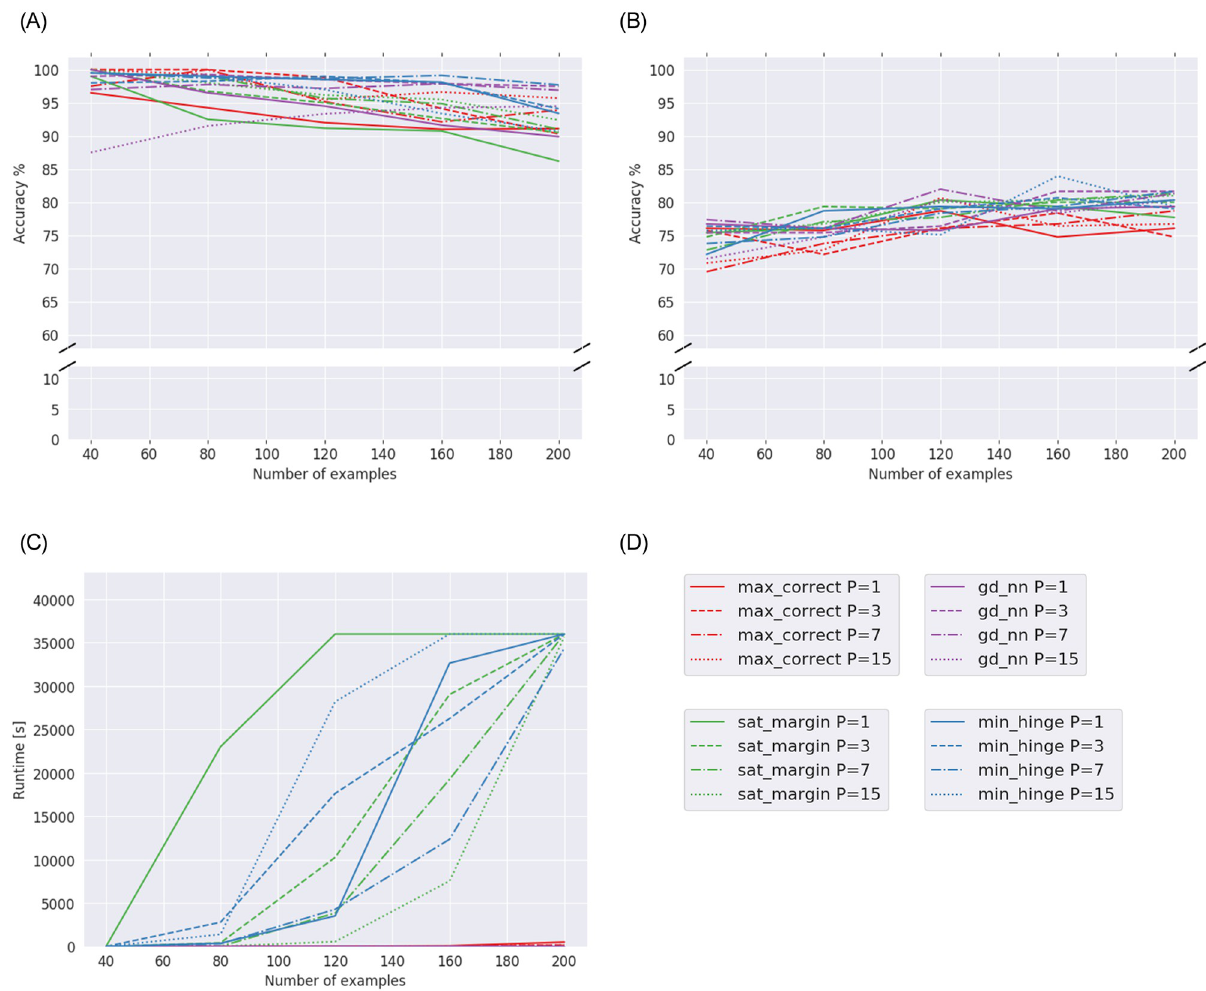
Fig 2. Results for Experiment 2B (Heart dataset), averages over five runs. (a) Training accuracy of models with different parameter ranges for Heart dataset. (b) Testing accuracy of models with different parameter ranges for Heart dataset. (c) Runtimes of models with different parameter ranges for Heart dataset.